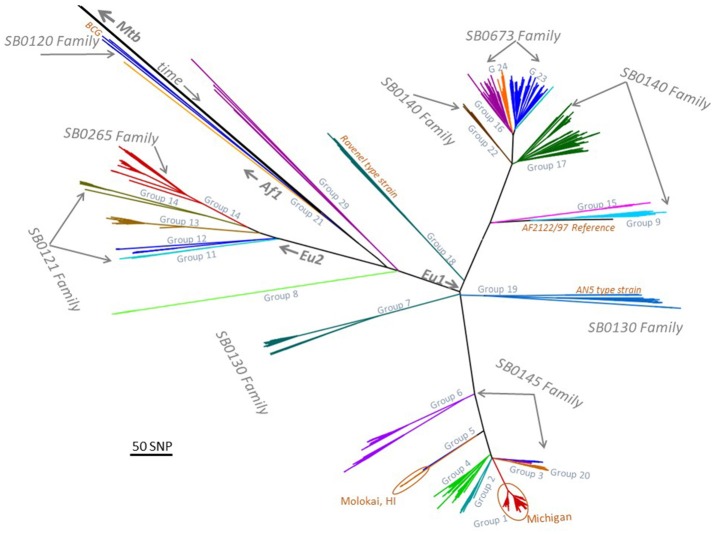
Low resolution phylogenetic tree representing 1,248 Mycobacterium bovis isolates and major spoligotyping families. MTBC, M. tuberculosis complex; EU1, European clonal complex 1; EU2, European clonal complex 2; Af1, African complex 1; SNP, single nucleotide polymorphism; BCG, bacille Calmette-Guerin; HI, Hawaii; AN5, M. bovis AN5 strain.